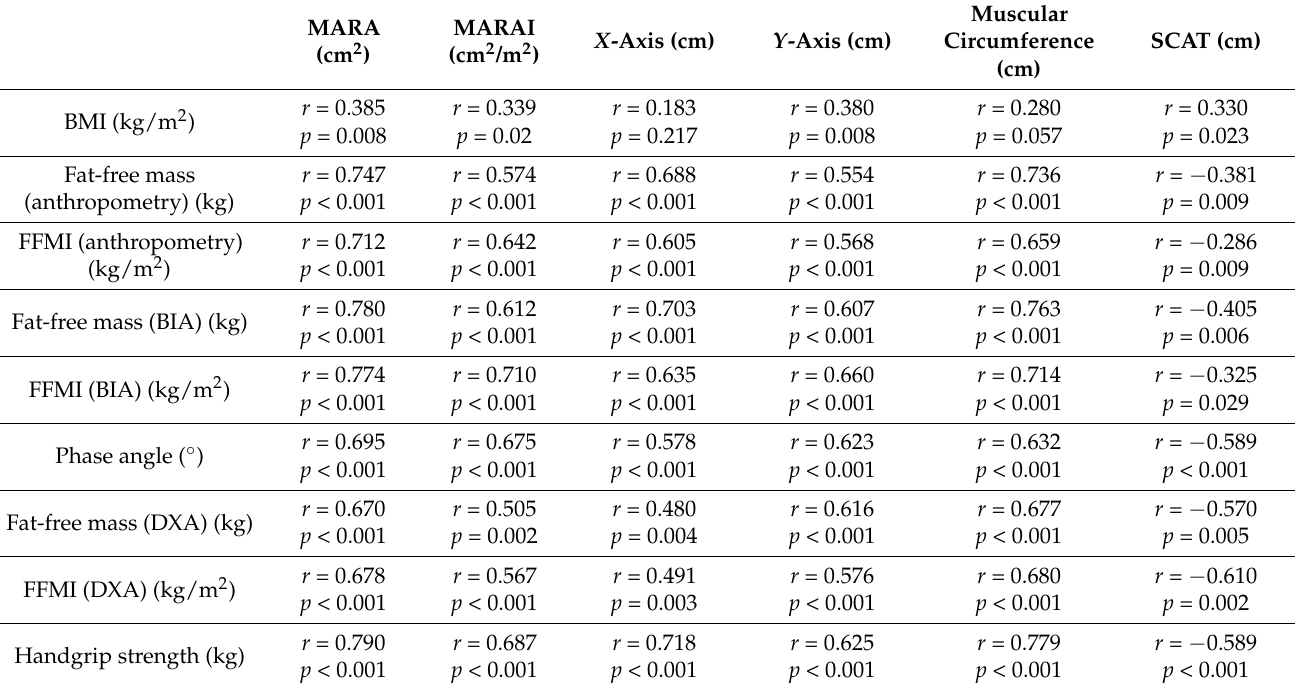
Table 3. Correlations between ultrasound and other morphofunctional